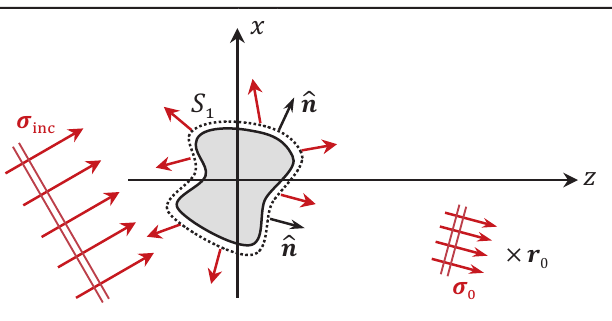
is scattered from a (cid:3167)(cid:3172)(cid:3161) ( (cid:2200) ) and (cid:2158) ( (cid:2200) ) . (cid:3046) (cid:3046)